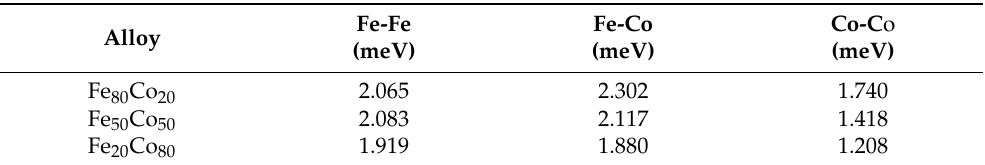
Table 2. The calculated nearest-neighbour exchange parameters in the framework of ab-initio density functional theory using the Korringa–Kohn–Rostocker Green’s function formalism, implemented in the SPRKKR package